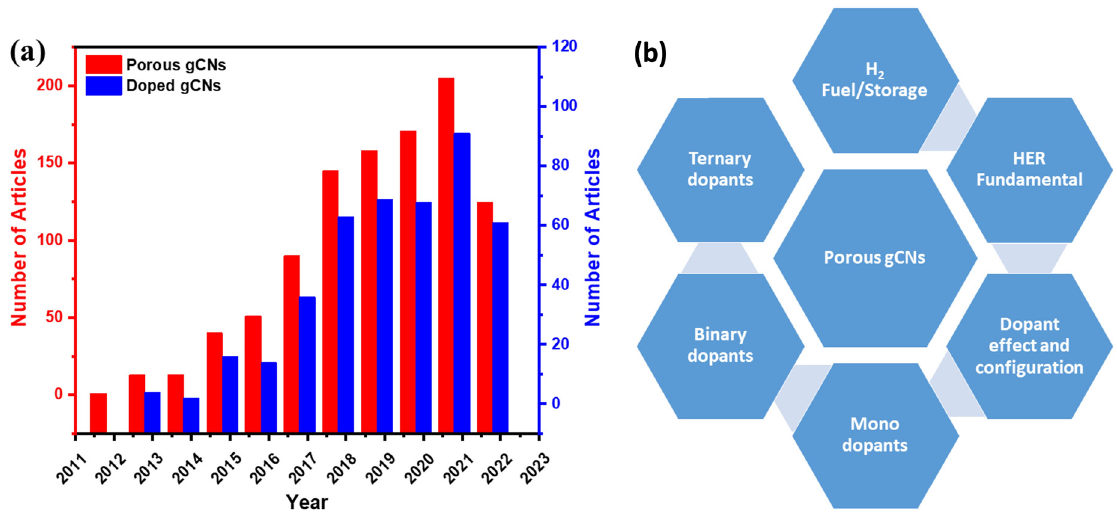
Figure 1. ( a ) The articles related to porous gCNs and doped gCNs published between 2012 and 18th October 2022, obtained from Web of Science data. ( b ) The overall focus of this review.